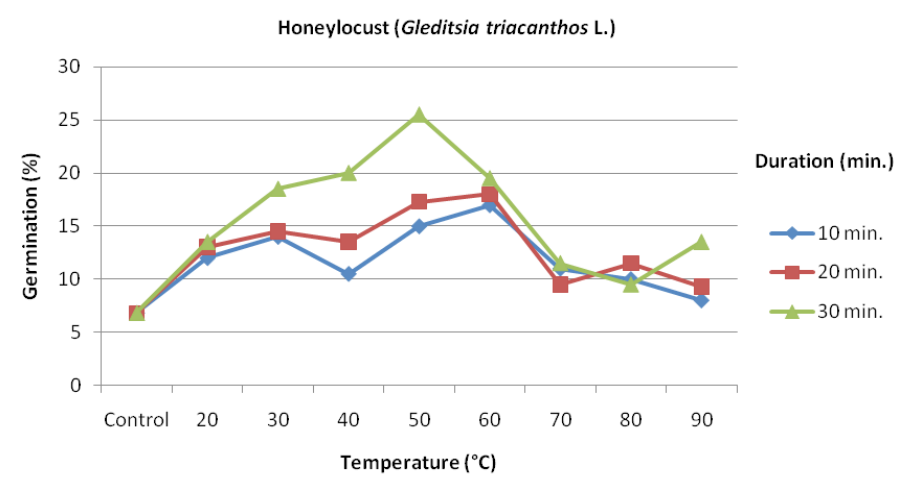
Fig. 2. The effect of different temperatures and durations on germination rates of honey locust ( Gleditsia triacanthos L.) seeds